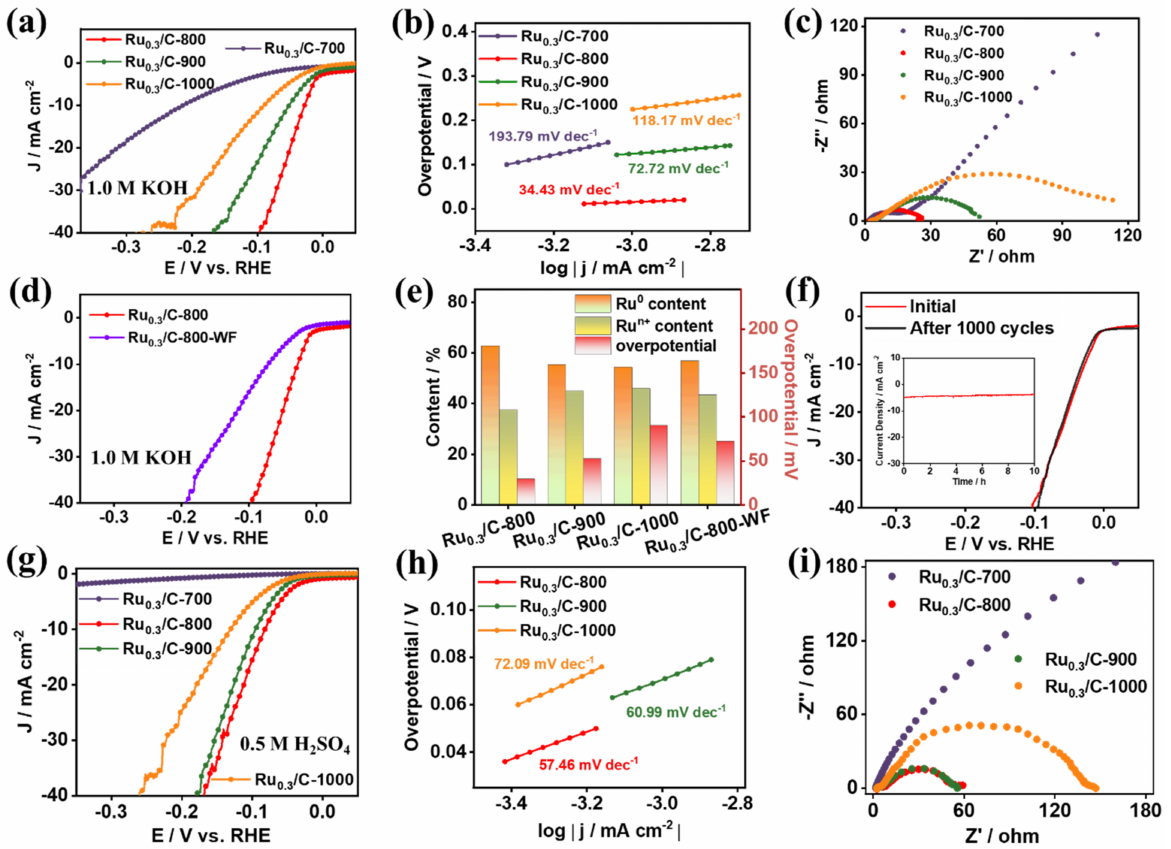
Figure 5. ( a ) LSV curves of Ru 0.3 /C − 700, Ru 0.3 /C − 800, Ru 0.3 /C − 900, and Ru 0.3 /C − 1000